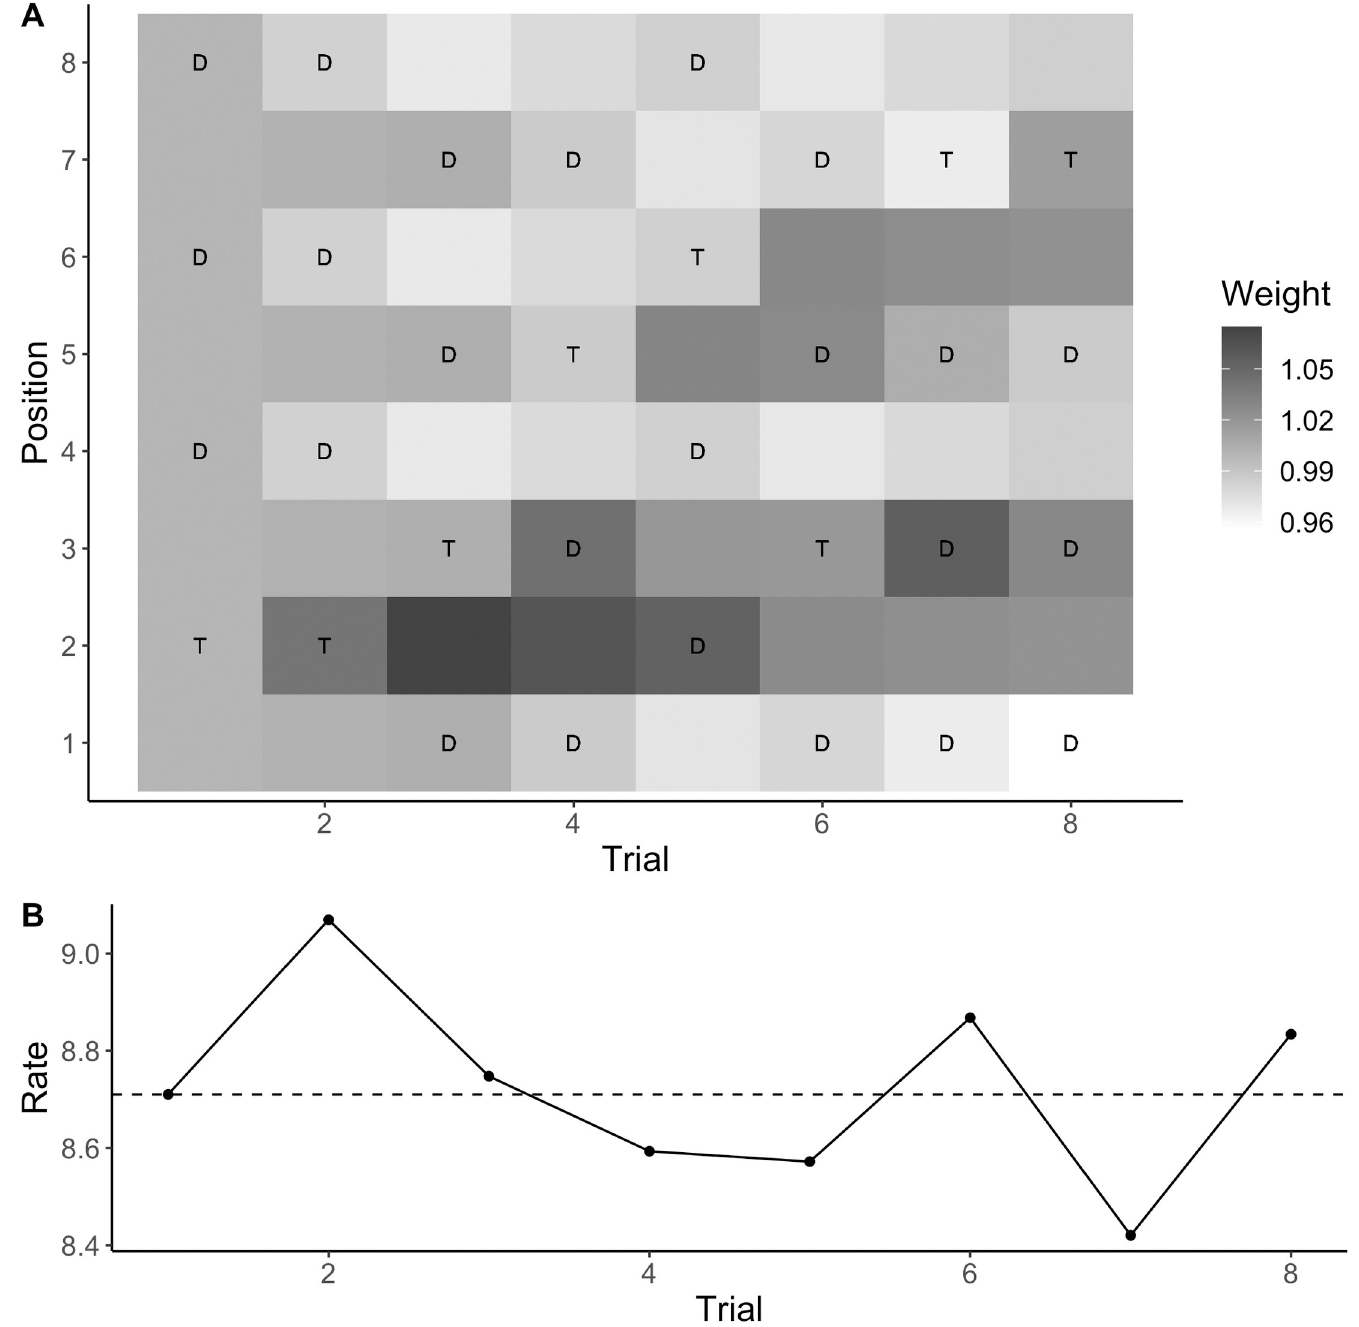
Fig 10. Example of position-based updating. Example of the weight changes to the different positions predicted by the “weighted rate with distractor inhibition” updating rule for the first eight trials of a typical participant (A), and the associated changes in the evidence accumulation rate on the same eight trials (B). The letters “T” and “D” denote the target position and, respectively, the positions of the three distractors on each trial. The dashed line marks the baseline evidence accumulation rate. The evidence accumulation rate on each trial was the baseline rate scaled by the weight associated with the target position on that